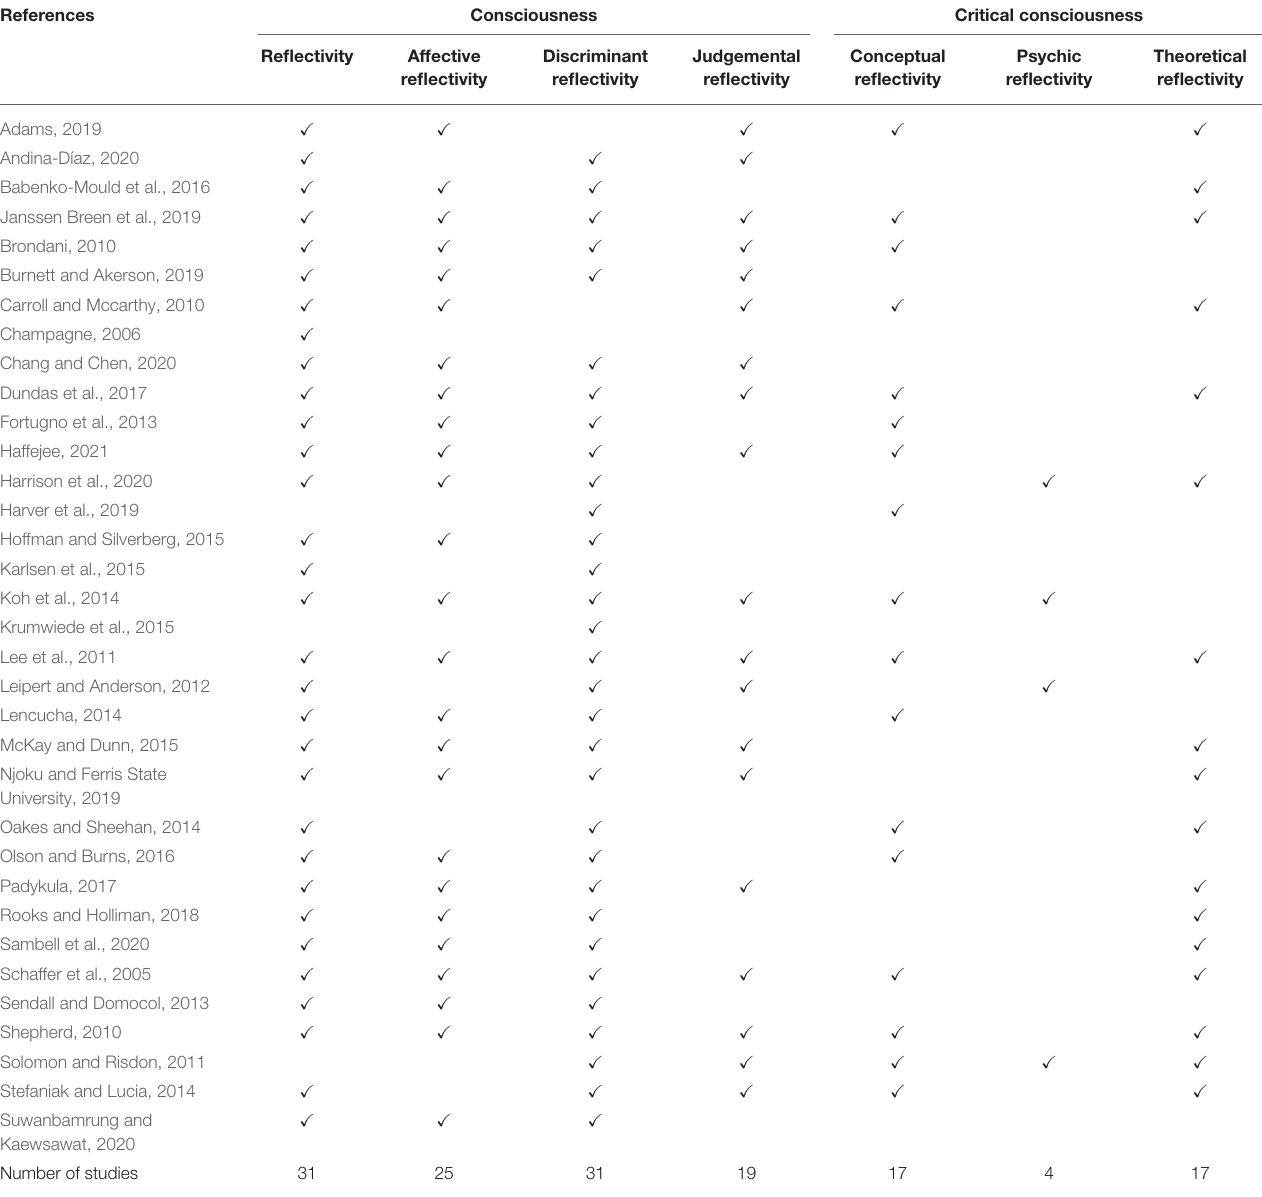
TABLE 2 | Evaluation of the levels and dimensions of self-reflection using the Mezirow’s